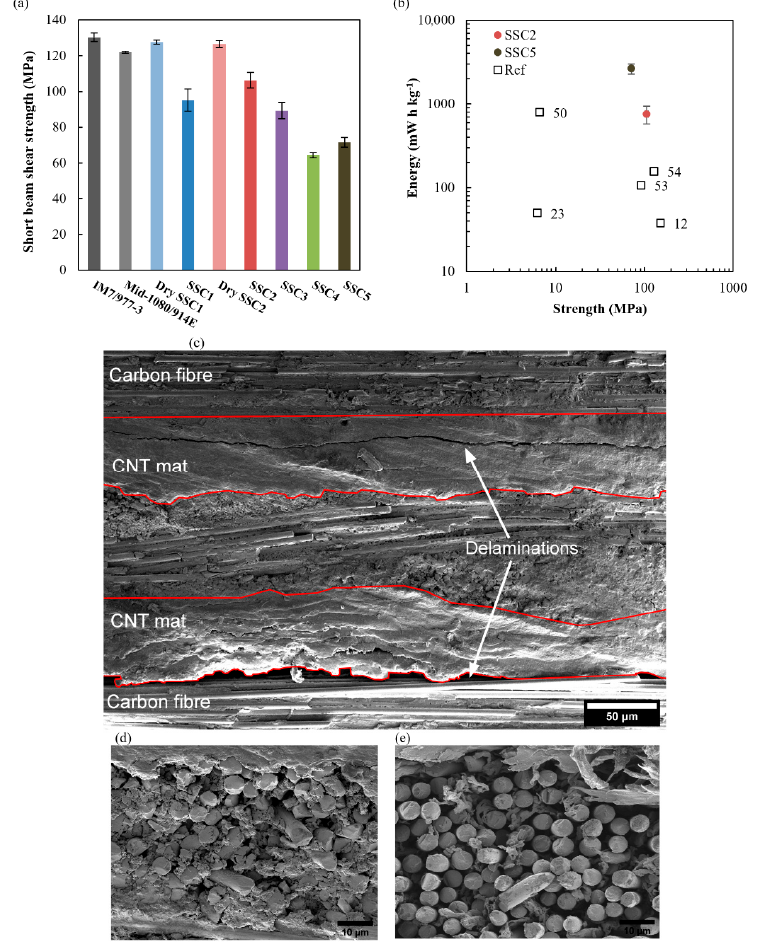
Figure 7. Mechanical performance of the baseline and SSC configurations showing ( a ) the SBS strength, ( b ) strength vs. energy plot with literature comparison [12,23,50,53,54], ( c ) delamination failure of SSC2, and ( d , e ) the morphology of the epoxy resin and ionogel matrices within the fibre- glass separator layer for SSC2 and SSC5, respectively. The additional benefit of the increased and more localised IL concentration in SSC5 and SSC2 is reflected in the energy and power density in Figure 6f, with SSC5 producing 2640 mW h kg − 1 at 8.37 W kg − 1 and SSC2 producing 758 mW h kg − 1 at 7.87 W kg − 1 . Whilst both configurations have relatively similar quantities of IL added prior to cure, the im- proved performance of the ionogel may be related to the configuration reducing mixing between the IL and epoxy during cure and, consequently, limiting the reduction in IL ionic mobility this mixing causes. The corresponding deterioration in performance for SSC1 and SSC4, as shown in Figure 6f, also correlates with the reduction in localised IL concentration shown in Figure 2 when the resin is left in the glass fibre prepreg for SSC1 and the reduced porosity of the ionogel shown in Figure 5 for SSC4. Similarly, in SSC3